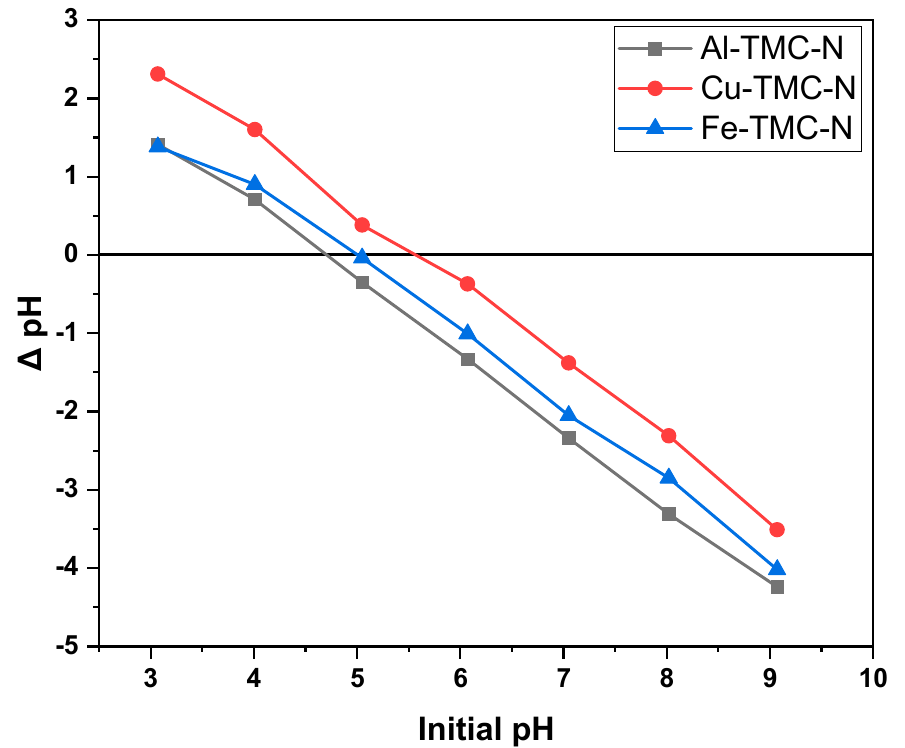
Figure 4. Determination of the PZC of the TMC materials via ∆ pH of the starting solution and pH after 48 h with adsorbent.